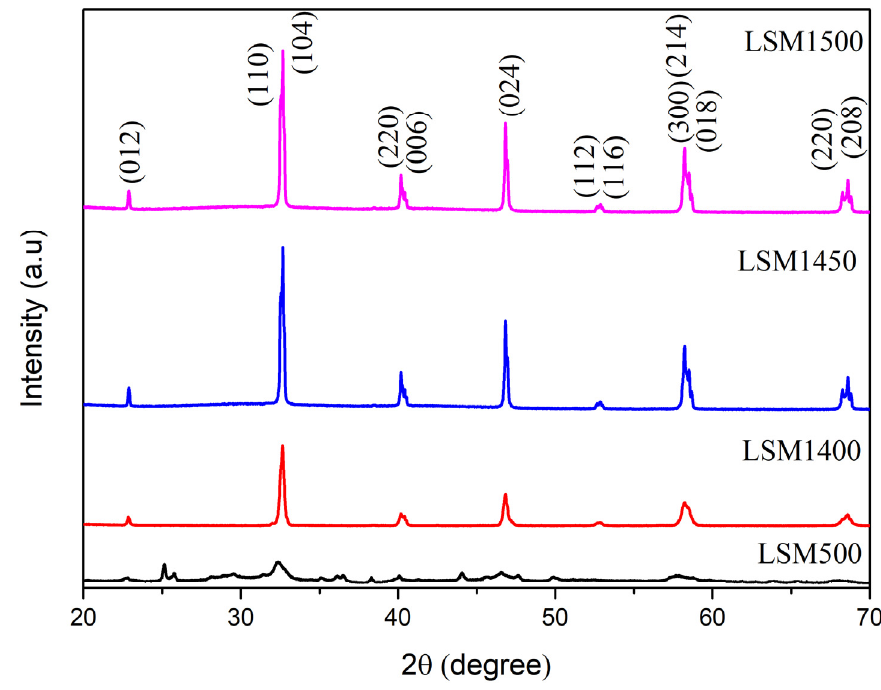
Figure 1. XRD patterns of La 0.6 Sr 0.4 MnO 3 combusted and calcined at 1400, 1450, and 1500 ◦ C for 8 h. For sample LSM 1400, the XRD data were modeled with the R-3c space group sym- metry as the main perovskite phase. The Pm-3m polymorph was included as the second phase in the refinement; this significantly improved the fit (goodness of fit (GoF)). The difference between the experimental data and the fitted simulated pattern is provided as a continuum. Figure S1 of the supplementary material shows the gray line as the best fit suggesting the coexistence of two distinct polymorphs of La 0.6 Sr 0.4 MnO 3 in the sample LSM1400 presenting the space group, 96.29% of R-3c and 3.71% of Pm-3m phases. This is likely because LaMnO 3 perovskites adopt a highly symmetric Pm-3m cubic structure at elevated temperatures [42,43]. Islam et al. explained that these ABO 3 -type perovskites can deviate from the ideal cubic structure due to distortions in the rigid BO 6 octahedra, i.e., by changes in the lengths of the B–O bonds, generating flexibility in the antisymmetric Jahn– Teller-type distortion of the BO 6 octahedra [44]. Thus, as the temperature decreases,